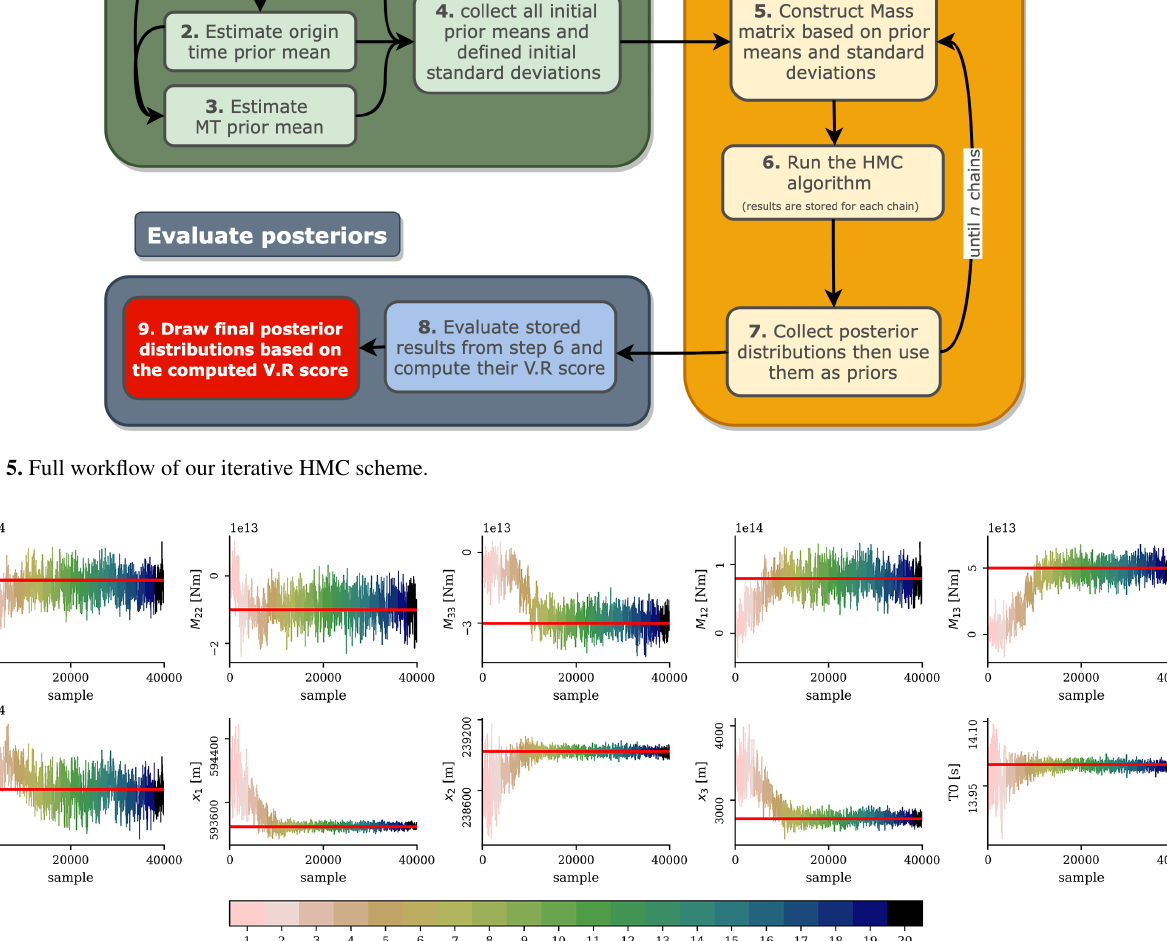
Figure 6. Results of our iterative HMC scheme for a total of 20 chains, each involving 2500 steps, the first 500 of which are discarded as burn-in samples (not shown). The red lines are the true